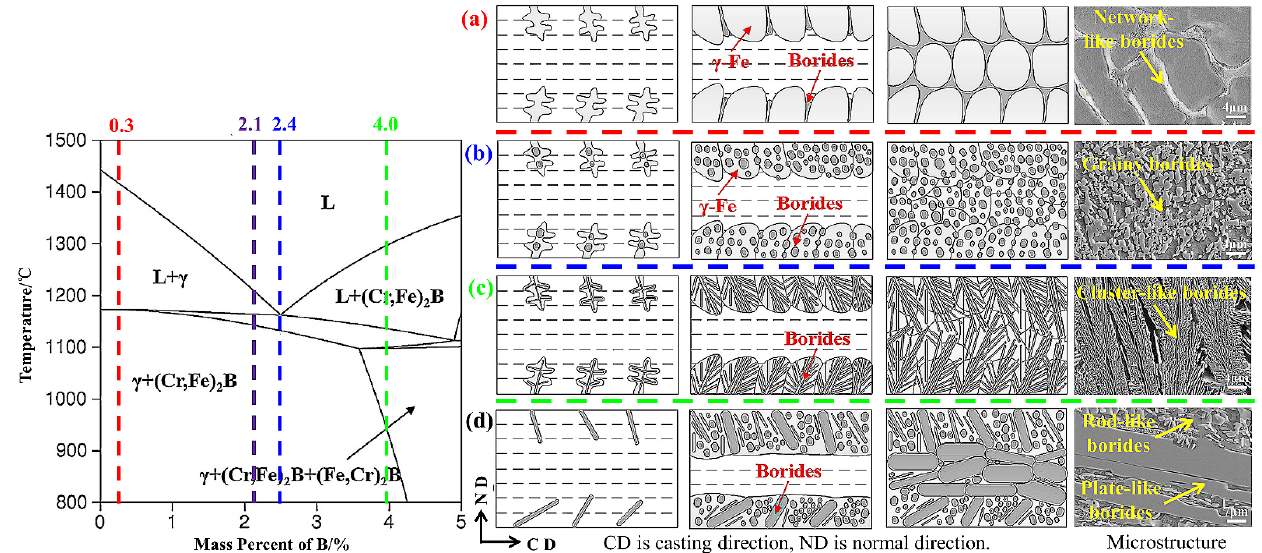
Figure 3. Pseudo-binary phase diagram of Fe–B and diagrams of solidification process of 0.3 wt% B ( a ), 2.4 wt% B ( b ), 4.0 wt% B ( c ) and solidification process of central microstructure ( d ) [25].